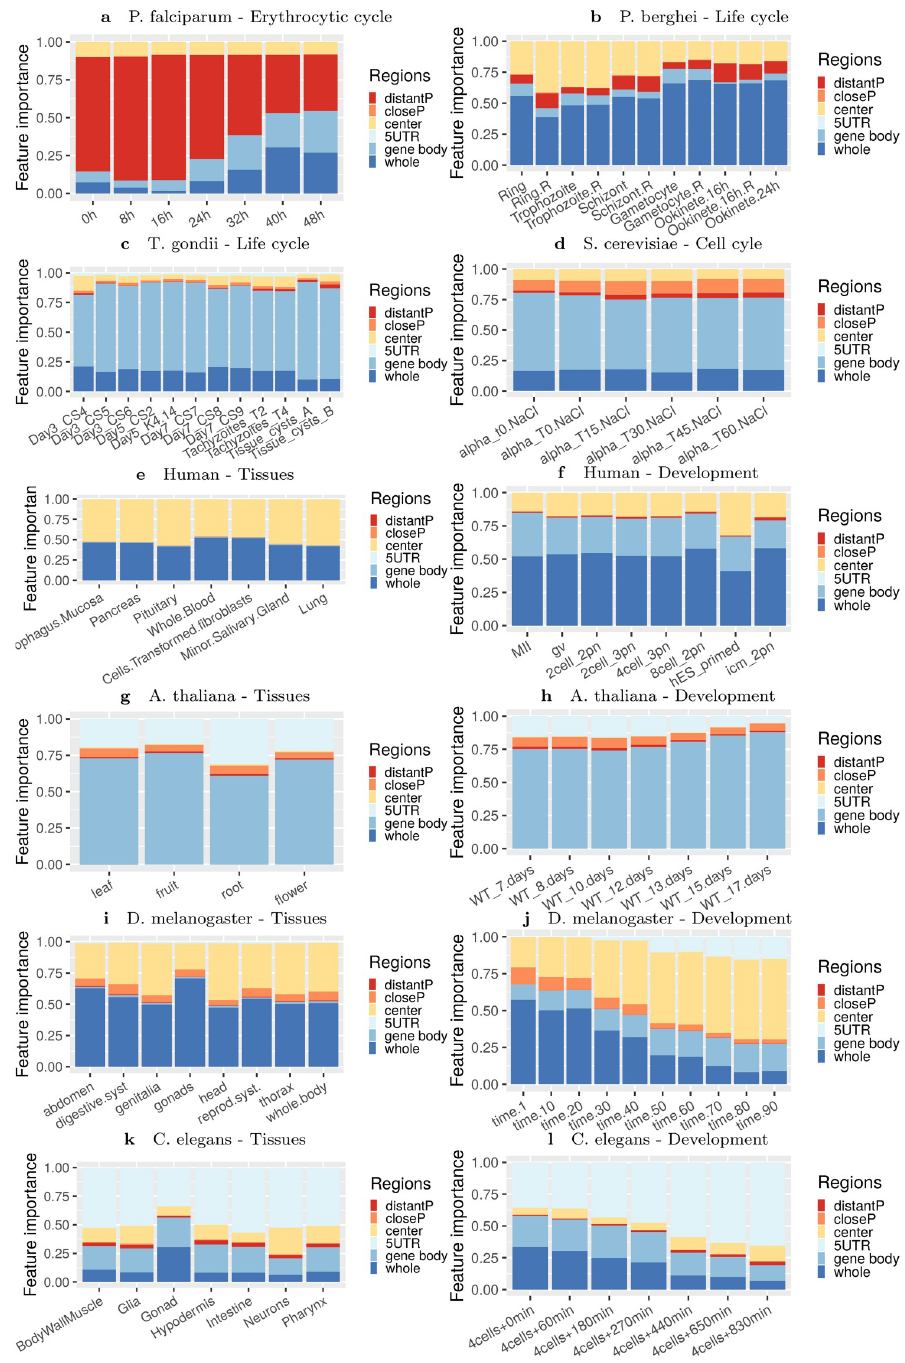
Fig 5. Relative importance of promoter, untranslated and coding regions for predicting gene expression in different species and conditions. For each condition, the 30 most important variables of the model were identified and a usage statistic reflecting the importance of the variables for the prediction was computed (see Materials and methods). Then, each variable was associated with one gene region (6 different regions were considered: distal and proximal promoters, center, 5’UTR, gene body, or whole; see Materials and methods), and the usage statistics of the variables that belong to the same region were cumulated.